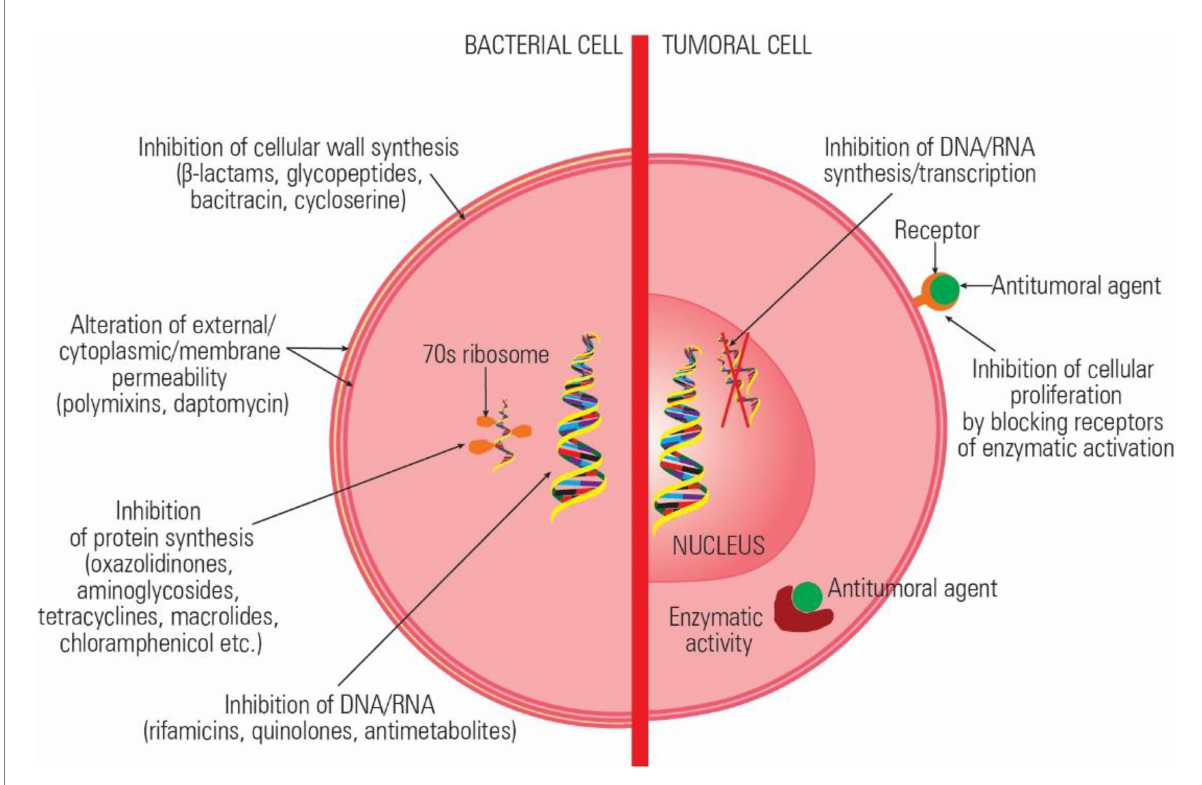
FIGURE 1 Comparative representation of the antibiotics and antitumoral agents’ mechanisms of